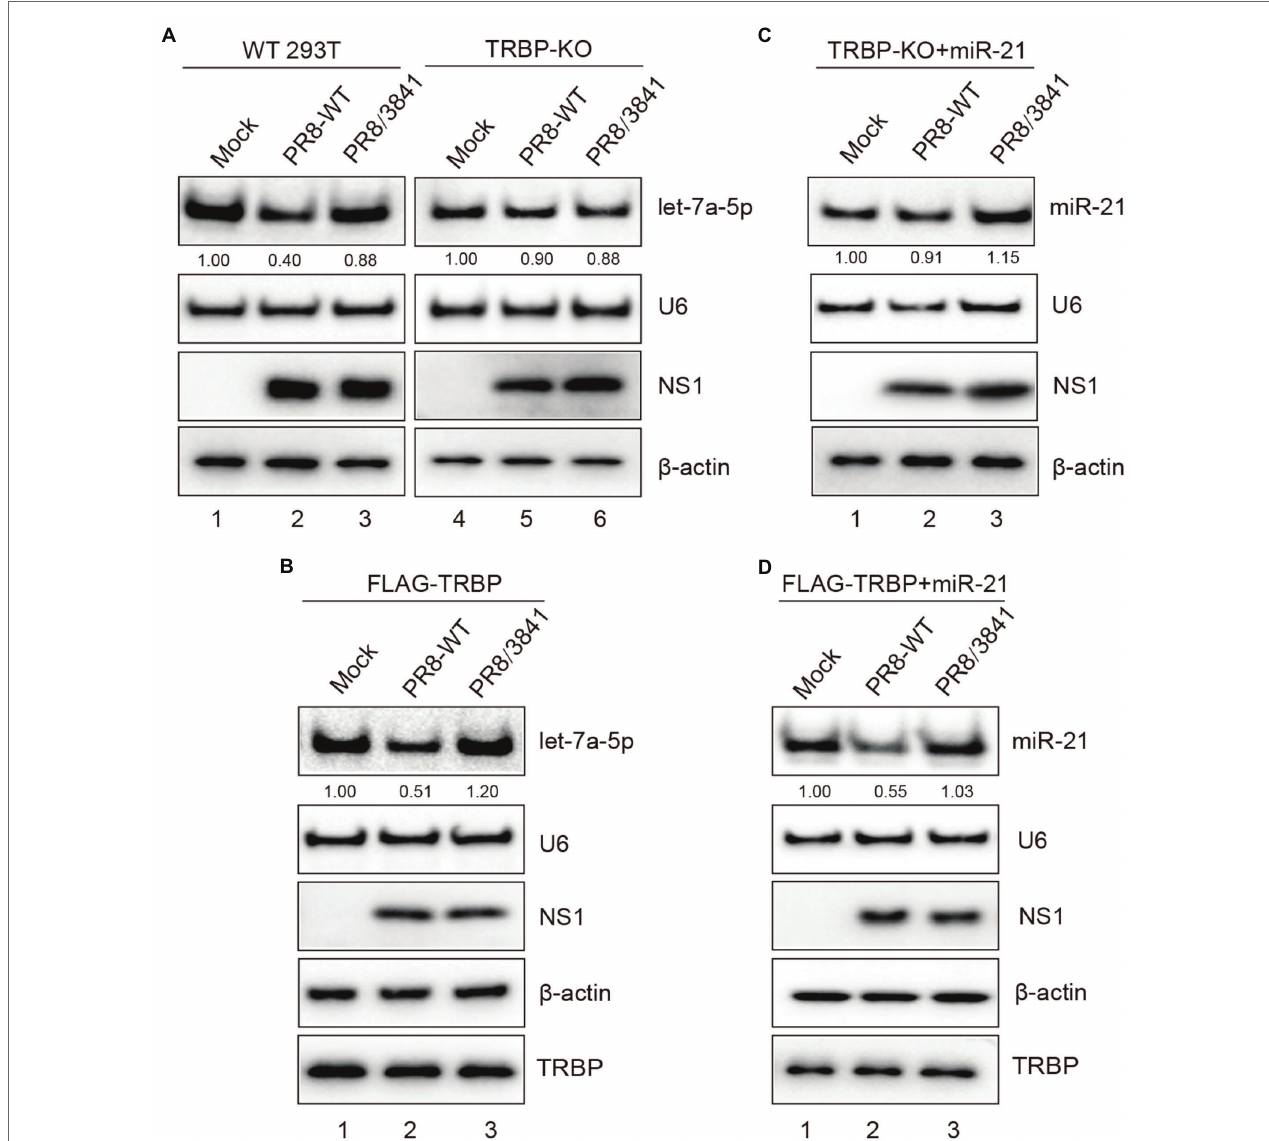
FIGURE 6 | NS1-TRBP interaction reduces miRNAs production. (A) The expression level of let-7a-5p is downregulated in PR8-infected WT cells. WT 293 T cells and TRBP-KO cells were infected with mock or PR8-WT (MOI = 1) or PR8/3841 (MOI = 1) for 48 h. Northern blotting and Western blotting were performed to detect expression levels of let-7a-5p, U6, NS1, and β -actin. The relative expression level of let-7a-5p is normalized to that of U6 small nuclear RNA and to the miRNA level from the uninfected WT 293 T cells or the uninfected TRBP-KO cells. (B) NS1-TRBP interaction reduces the expression of endogenous let-7a-5p. TRBP-KO cells were transfected with FLAG-TRBP for 24 h before infected with PR8-WT or PR8/3841 for 24 h. Northern blotting detection of let-7a-5p and U6 expressions. The relative expression level of let-7a-5p is normalized to that of U6 small nuclear RNA and to the miRNA level from the uninfected cells. Western blotting detection of TRBP, NS1, and β -actin proteins. (C, D) NS1-TRBP interaction reduces the expression of exogenous miR-21. (C) TRBP-KO cells were transfected with a miR-21 expressing plasmid for 24 h before infected with mock or PR8-WT or PR8/3841 for 24 h. (D) TRBP-KO cells were co-transfected with FLAG-TRBP and miR-21 expressing plasmid for 24 h before infected with mock or PR8-WT or PR8/3841 for 24 h. Northern blotting detection expressions of miR-21 and U6. The relative expression level of miR-21 is normalized to that of U6 small nuclear RNA and to the miRNA level from the uninfected cells. Western blotting detection of TRBP, NS1, and β -actin